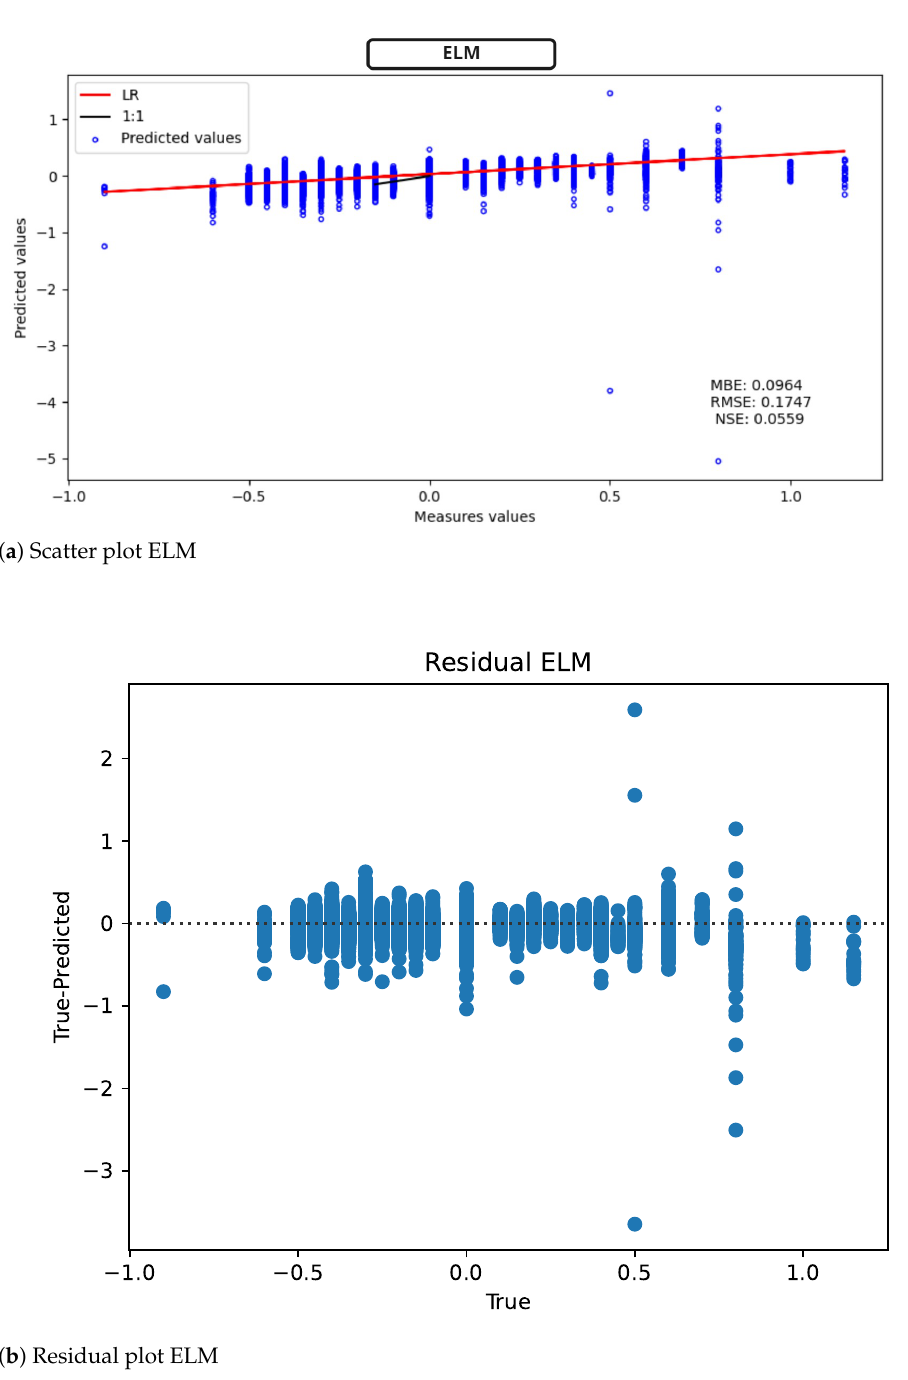
Figure 10. ELM results for ST deviation calculation in ECG time